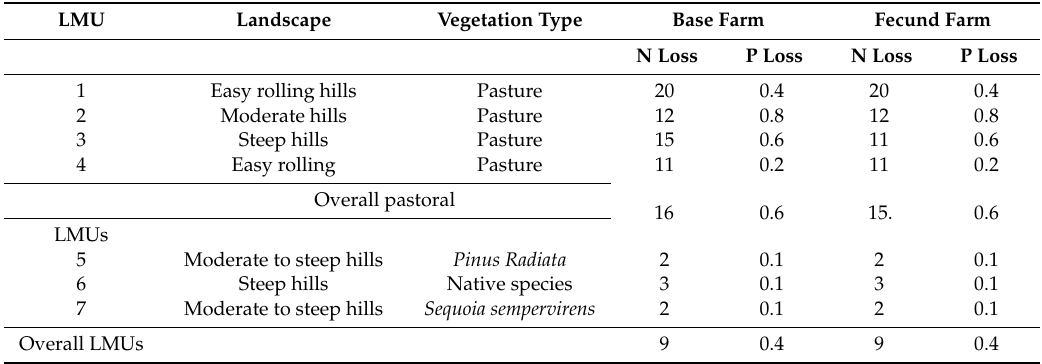
Table 5. Land management Units and OVERSEER ® Nitrate leaching (kgN / ha) and phosphorus loss risk (kgP / ha) output for each of the LMUs and the